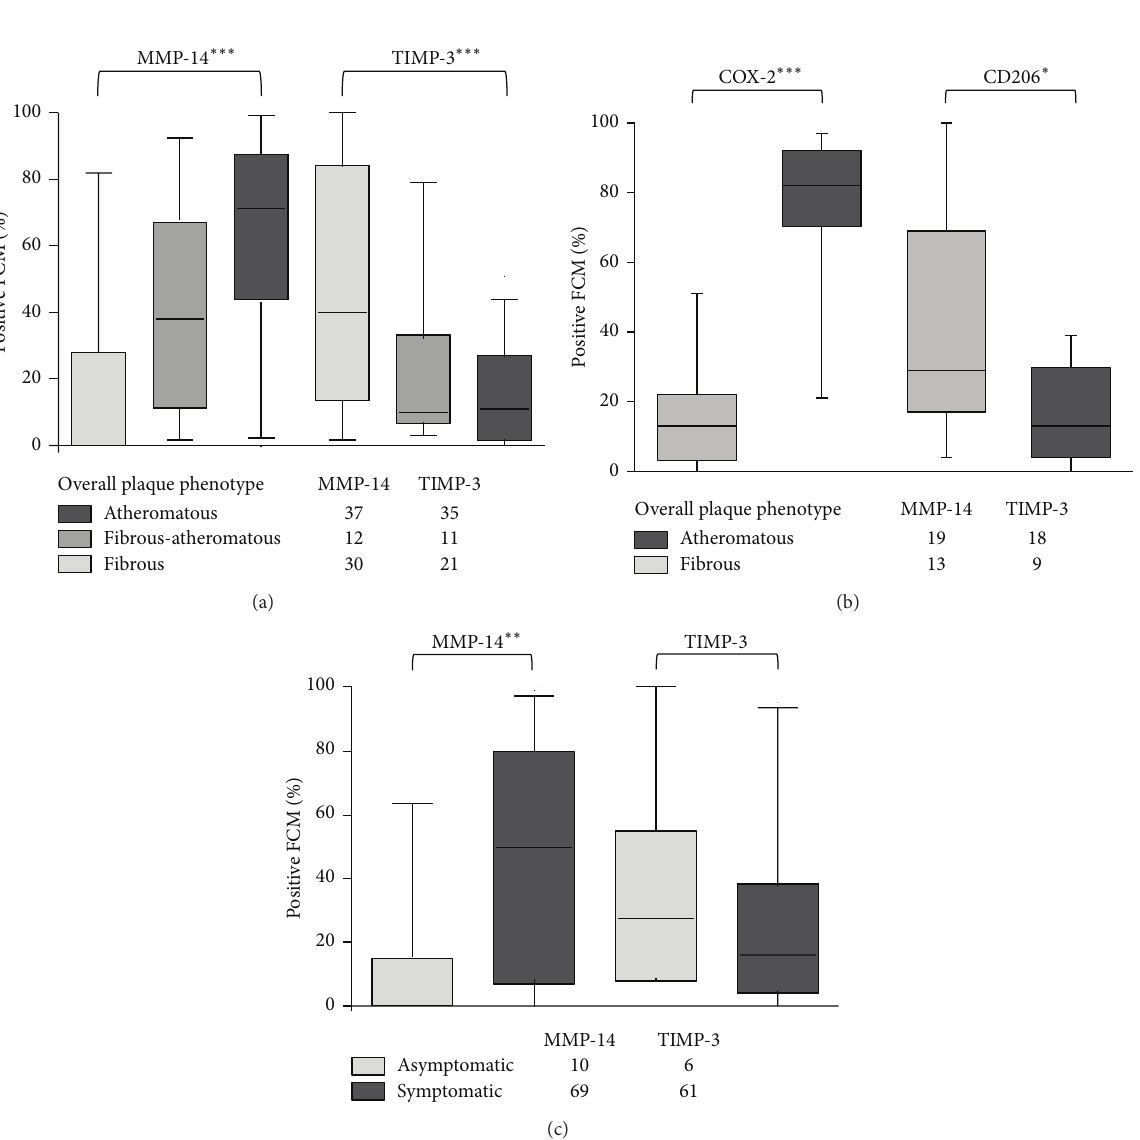
Figure 6: Relationship between MMP-14 and TIMP-3 staining and plaque morphology or symptoms. The percentage of CD68 positive FCMs that stained also for (a) MMP-14 and TIMP-3, or (b) COX-2 and CD206, was related to atheromatous, fibrous-atheromatous and fibrous carotid plaques. (c) Association of FCMs that stained also for MMP-14 and TIMP-3 was assessed in symptomatic and asymptomatic patients. Data analyzed using a Kruskal-Wallis test ( ∗ 𝑃 < 0.05 , ∗∗ 𝑃 < 0.01 , ∗∗∗ 𝑃 < 0.001 ). Patient numbers within each group are depicted below each bar